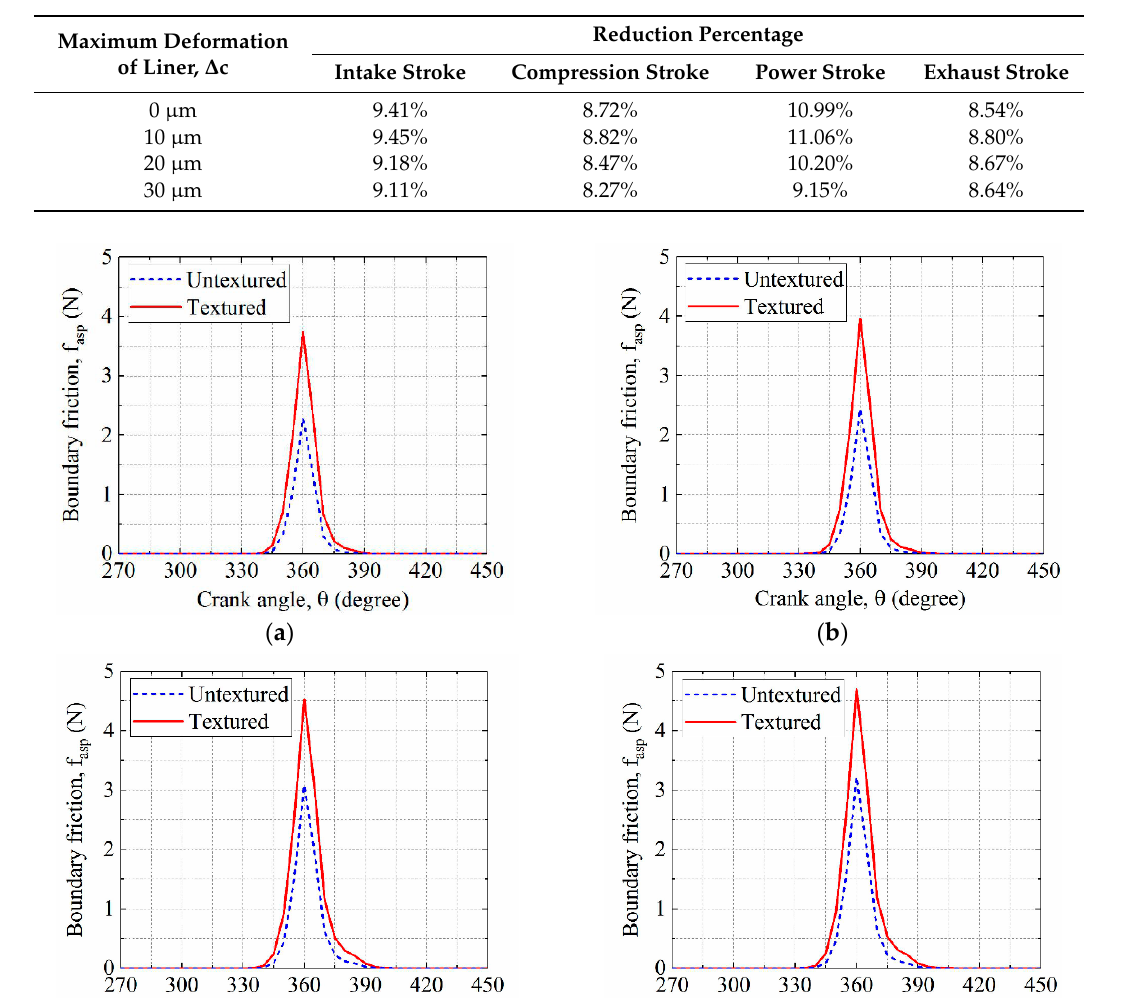
Table 3. Reduction percentages of the hydrodynamic friction force at the middle of strokes for di ff erent maximum liner deformations.